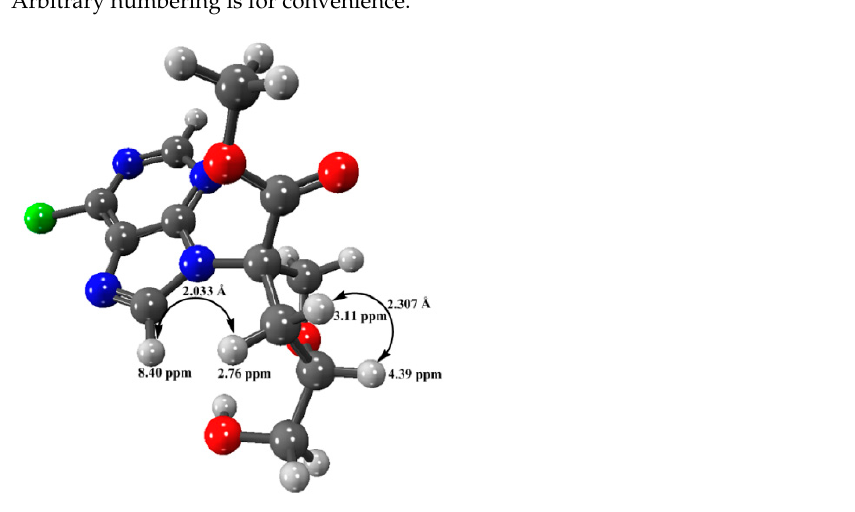
Figure 4. Experimental NOE correlations observed for compound 5 , supported by the energy-minimized structure shown here, obtained by DFT calculation in chloroform.